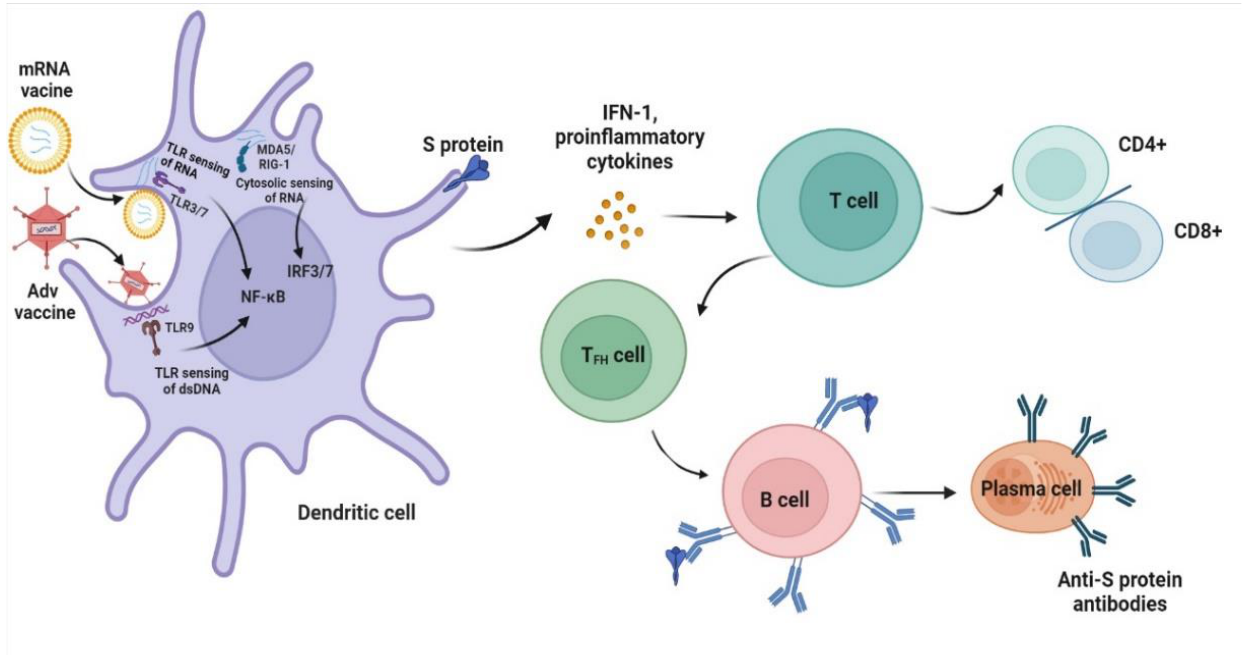
Figure 2. Proposed mechanisms of minimal change disease caused by COVID-19 vaccination. After mRNA vaccines and adenovirus (AdV) vector vaccines enter dendritic cells, high levels of S protein are produced. In addition, innate sensors such as endosomal T Toll-like receptor (TLR3 and TLR7) sensing of RNA and TLR9 binding double-stranded DNA (dsDNA) activate nuclear factor κ B (NF- κ B), and cytosolic sensing of melanoma differentiation-associated protein 5 (MDA5) and retinoic acid-inducible gene I (RIG-I) activate IFN regulatory factor 3/7 (IRF3/7), leading to the production of type I interferon (IFN-I) and proinflammatory cytokines. The resultant activated dendritic cells present antigens and costimulatory molecules to S protein-specific naive T cells and promote the adaptive immune response of T and B cells. The figure refers to the pathogenesis of a normal immune reaction in contact with pathogens by Sprent et al. [104.